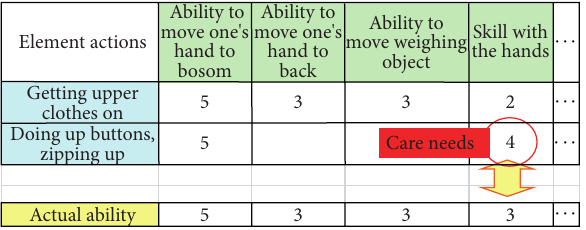
Figure 6: Example of Function 3–1 (partial).